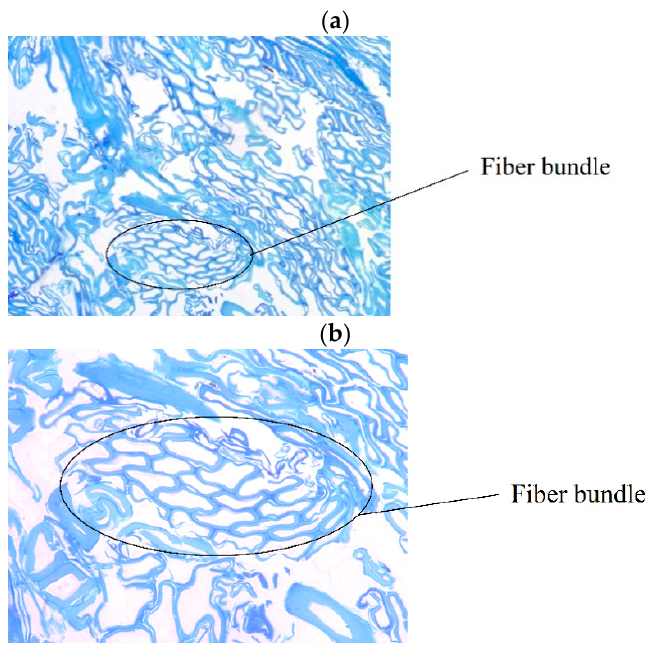
Figure 9. Images of mat porosity at 810 kg m − 3 with the same fiber bundle at different magnifications: ( a ) 20×, ( b ) 40×.